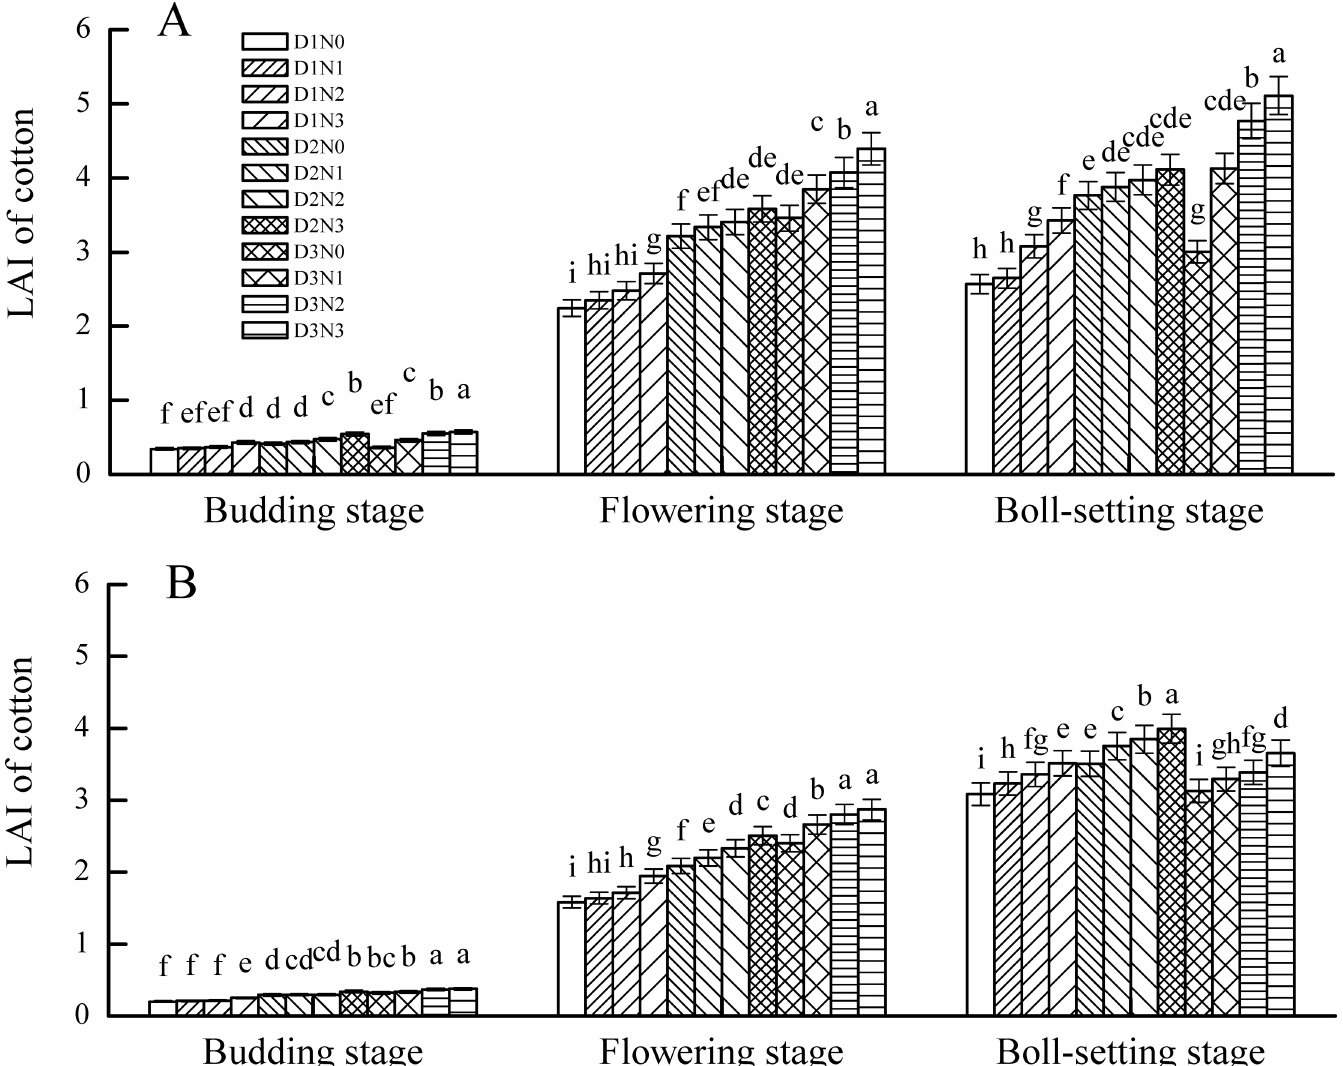
Fig 1. Leaf area index(LAI)of cotton at different growth periods in 2013(A)and 2014(B)Note: D1, D2, D3 indicateplantingdensity at 3.00, 5.25, 7.50 plants m − 2 respectively,and N0, N1, N2, N3, N4 indicatenitrogenapplicationrate at 0, 112.5, 225.0, 337.5 kg ha − 1 respectively. A, B indicate2013 and 2014. Numbers at the same growth stage followedby the same small alphabetare not significantly different at the 5%